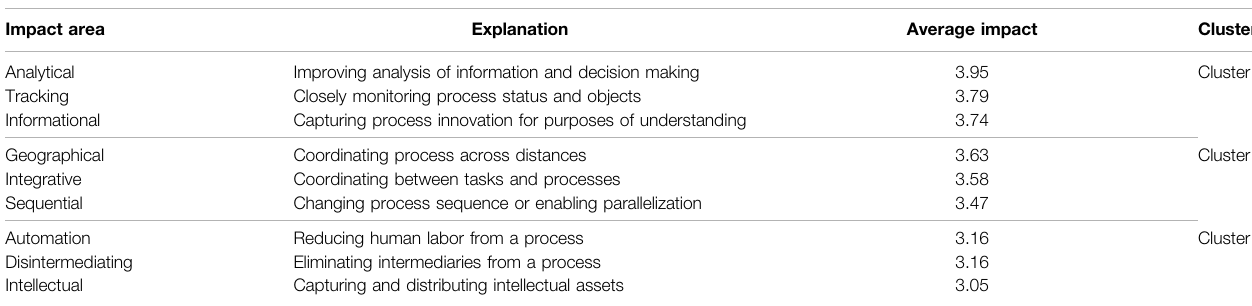
TABLE 8 | Clustered table of the impact areas of AR on